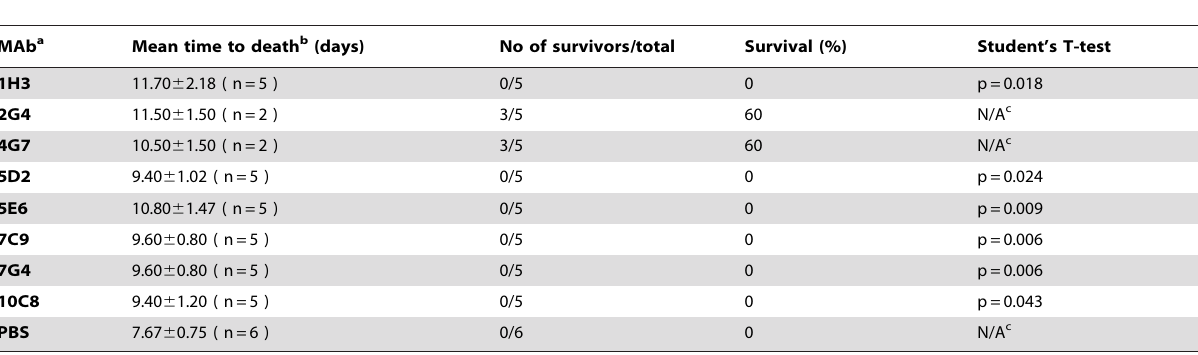
Table 4. Prolonged survival seen in MAb-treated guinea